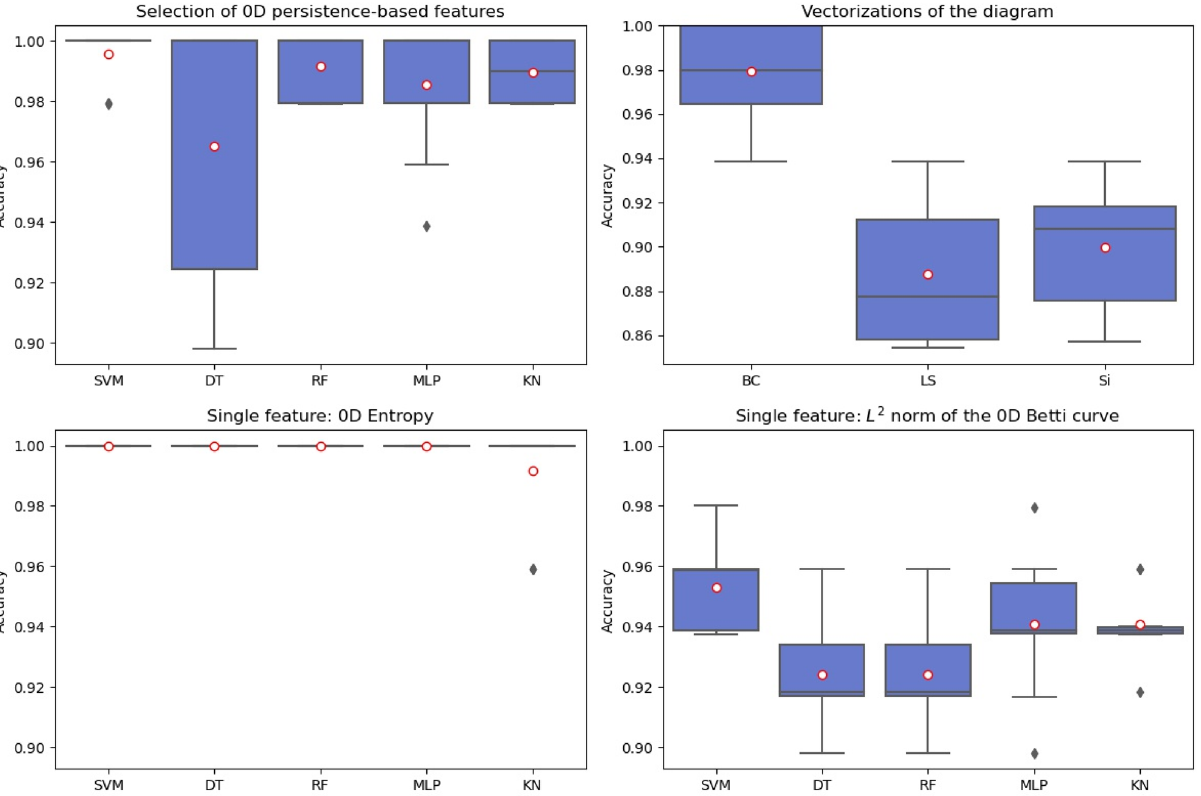
Figure 6. Persistence-based parameters and classification accuracy obtained for classifiers SVM, DT, RF, MLP, and KN after hyperparameter optimisation (input: all 0D persistence-based parameters, 0D entropy, L 2 -norm of Betti curve). In addition, performance of 3 vectorizations of persistence diagrams in the upper right subplot. Mean values as red circles. Note the different y-limits for the accuracy values for the higher order vectorizations of the persistence diagrams.